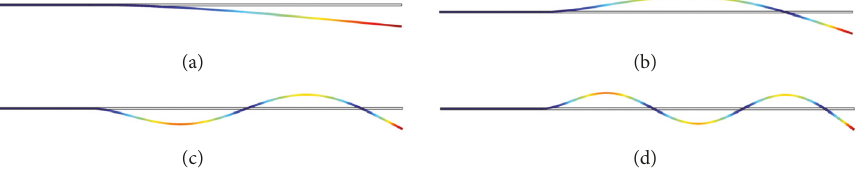
Figure 3: First four modal shapes and modal frequencies of the considered piezoelectric device: (a) 𝜔 1 = 316rad/sec, (b) 𝜔 2 = 1980 rad/sec, (c) 𝜔 3 = 5545 rad/sec, and (d) 𝜔 4 = 10866 rad/sec.